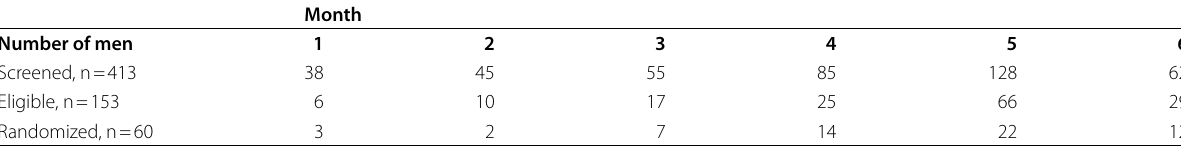
Table 3 Number of men recruited per month